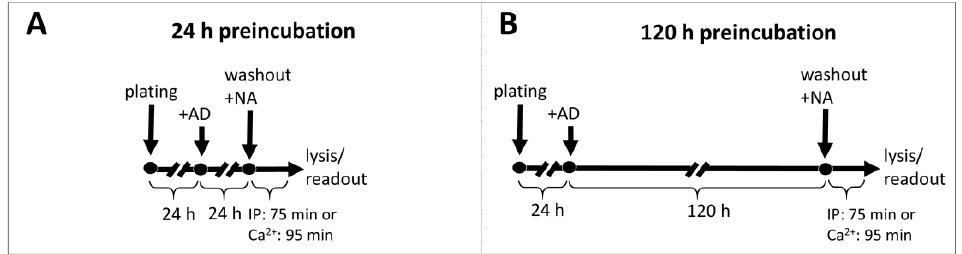
Figure 4. Timelines of experiments testing prolonged (24 h ( A ) and 120 h ( B )) preincubation of cells expressing α 1-AR subtypes with antidepressants. AD—antidepressant drug;